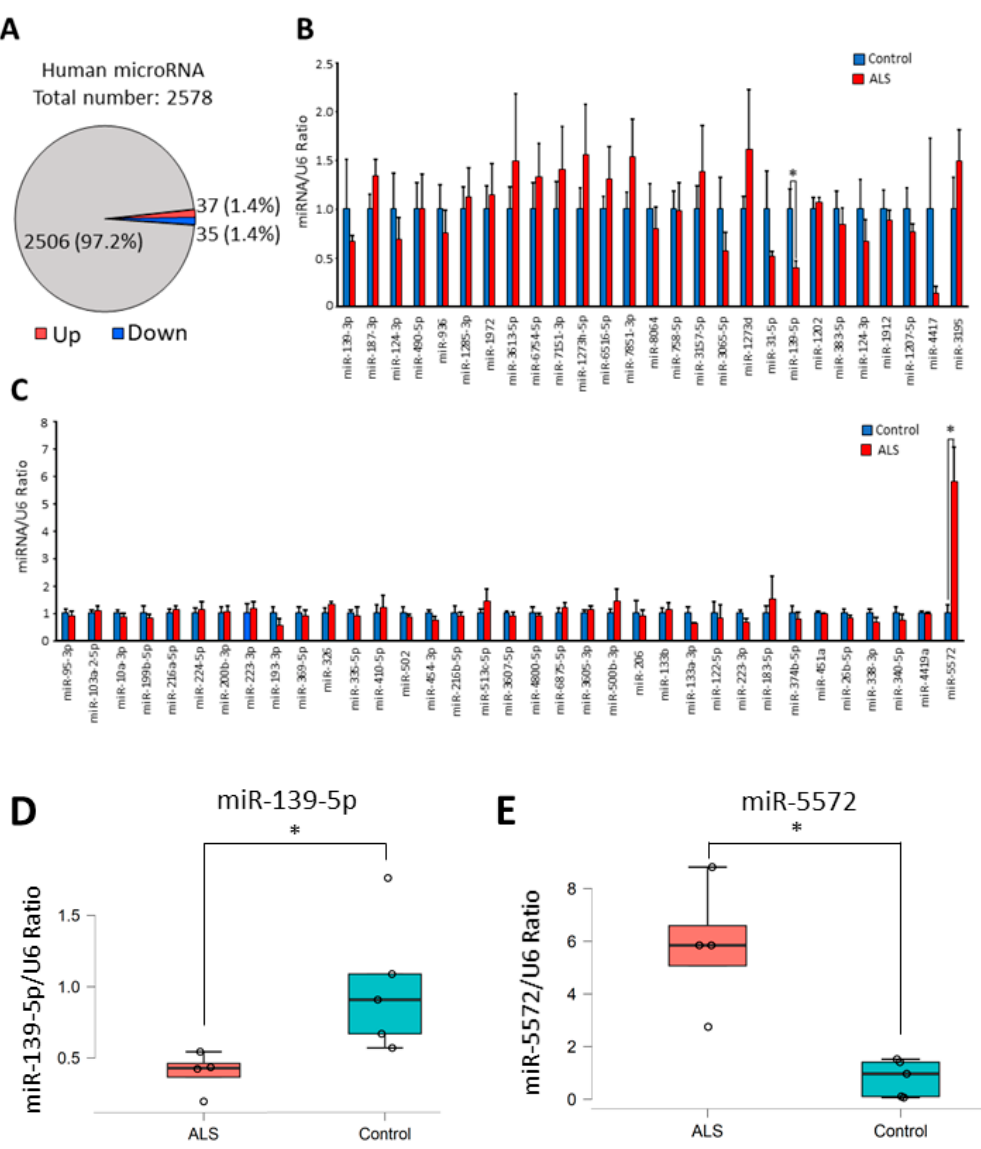
Figure 1. Global analysis of microRNA (miRNA) expression in sporadic amyotrophic lateral sclerosis (sALS) was performed using spinal cord samples from patients with sALS. ( A ) The number or ratio of altered miRNAs in sALS is presented. More than twofold changes in miRNA levels were calculated from the result of microarray analysis. ( B ) Decreases in miRNA levels in the microarray were confirmed by real-time RT-PCR analysis. All data are presented as mean ± standard error. Statistical significance between control ( n = 5) and sALS ( n = 4) group in each miRNA was determined by Student’s t -test (* p < 0.05). ( C ) Increases in miRNA levels in the microarray were confirmed by real-time RT-PCR analysis. All data are presented as mean ± standard error. Statistical significance between control ( n = 5) and sALS ( n = 4) group in each miRNA was determined by Student’s t -test (* p < 0.05). ( D ) Re-plotted individual data (control; n = 5 and sALS; n = 4) of miR-139-5p / U6 ratio in Figure 1B are presented as box and scatter plot. Statistical significance was determined by Student’s t -test (* p < 0.05). ( E ) Re-plotted individual data (control; n = 5 and sALS; n = 4) of miR-5572 / U6 ratio in Figure 1B are presented as box and scatter plot. Statistical significance was determined by Student’s t -test (* p <